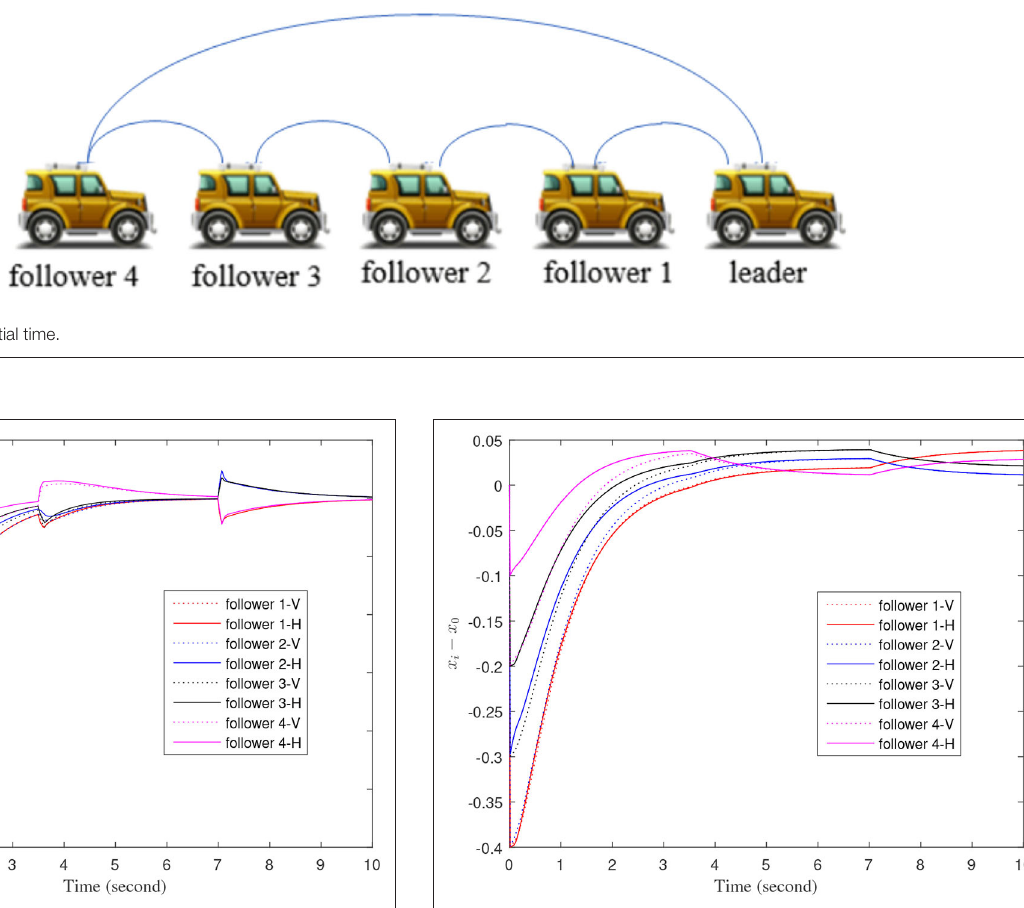
FIGURE 4 | The real-time distance between each follower car and the leader